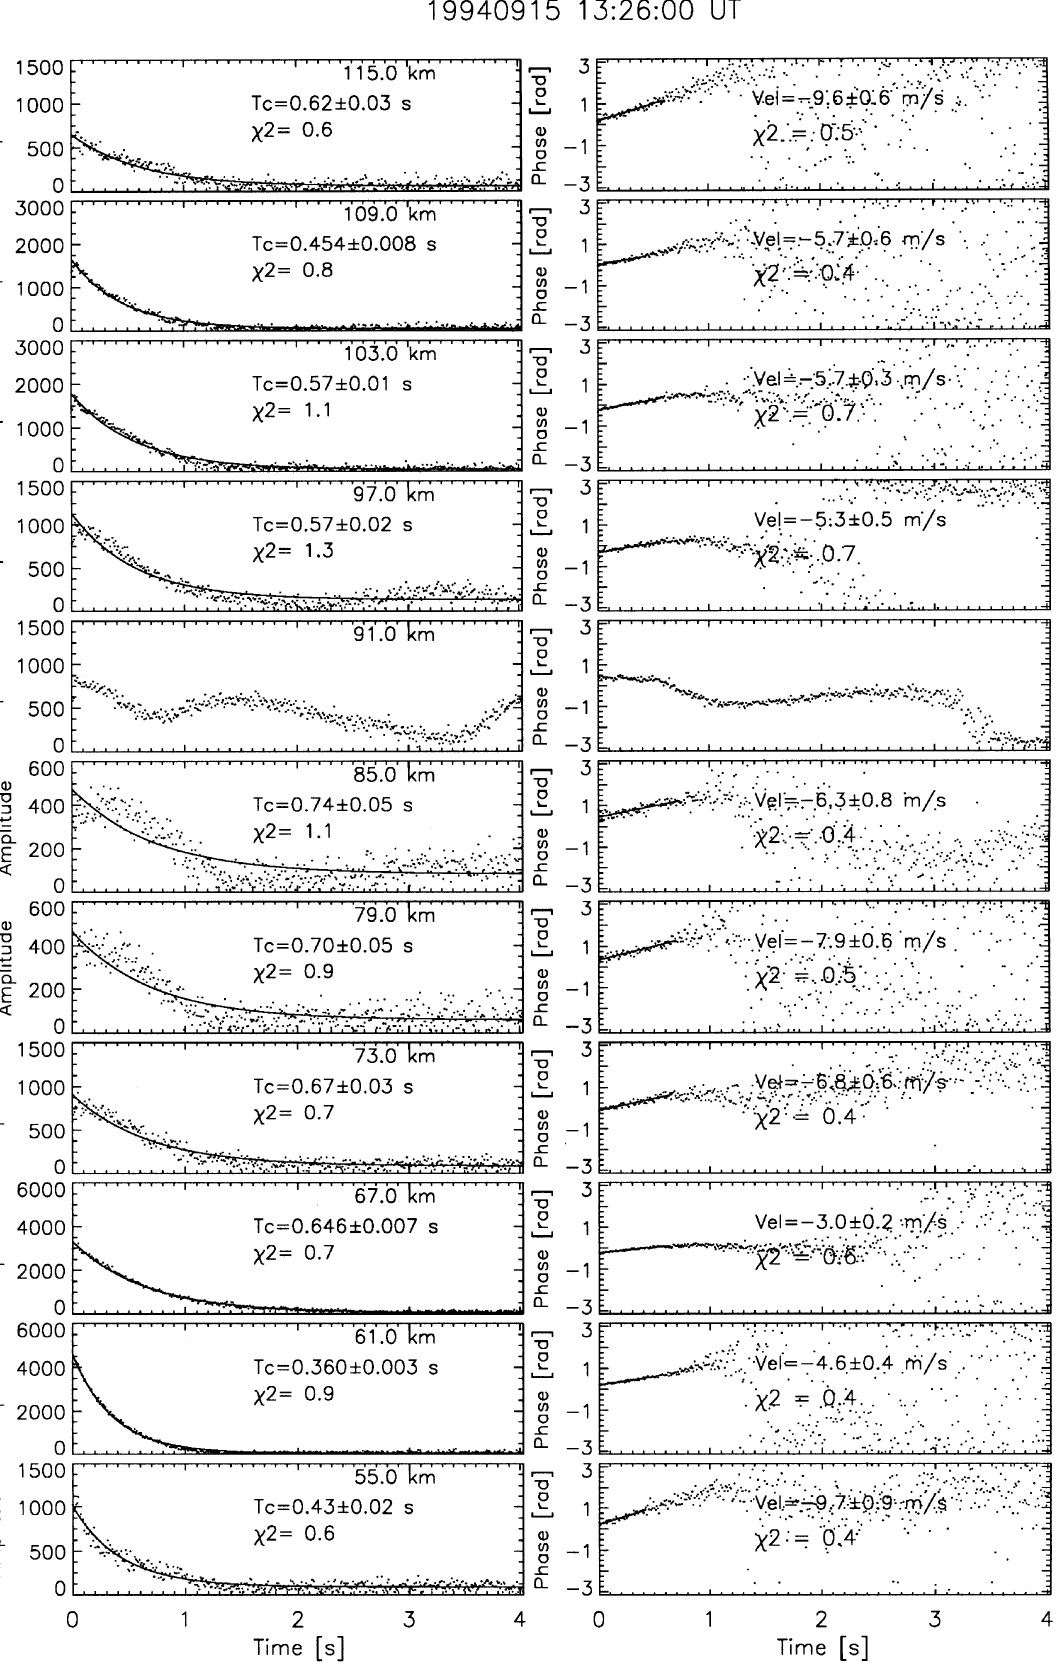
because of the predominance of natural irregularities also in evid- ence at 79 and